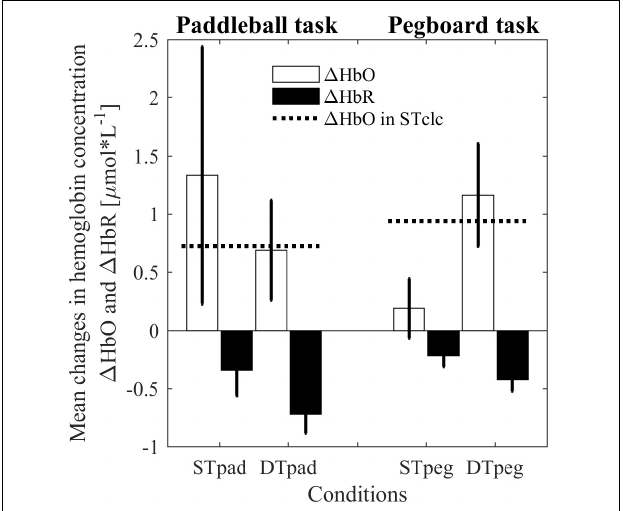
FIGURE 5 | Changes in hemoglobin concentrations for HbO (white bars) and HbR (black bars) as indication of processing load in prefrontal brain region for paddleball (pad) and pegboard (peg) task under single (ST) und dual-task (DT) conditions. The dashed horizontal lines represent cortical activity induced by single-task calculations (STclc). Error bars represent standard errors of the